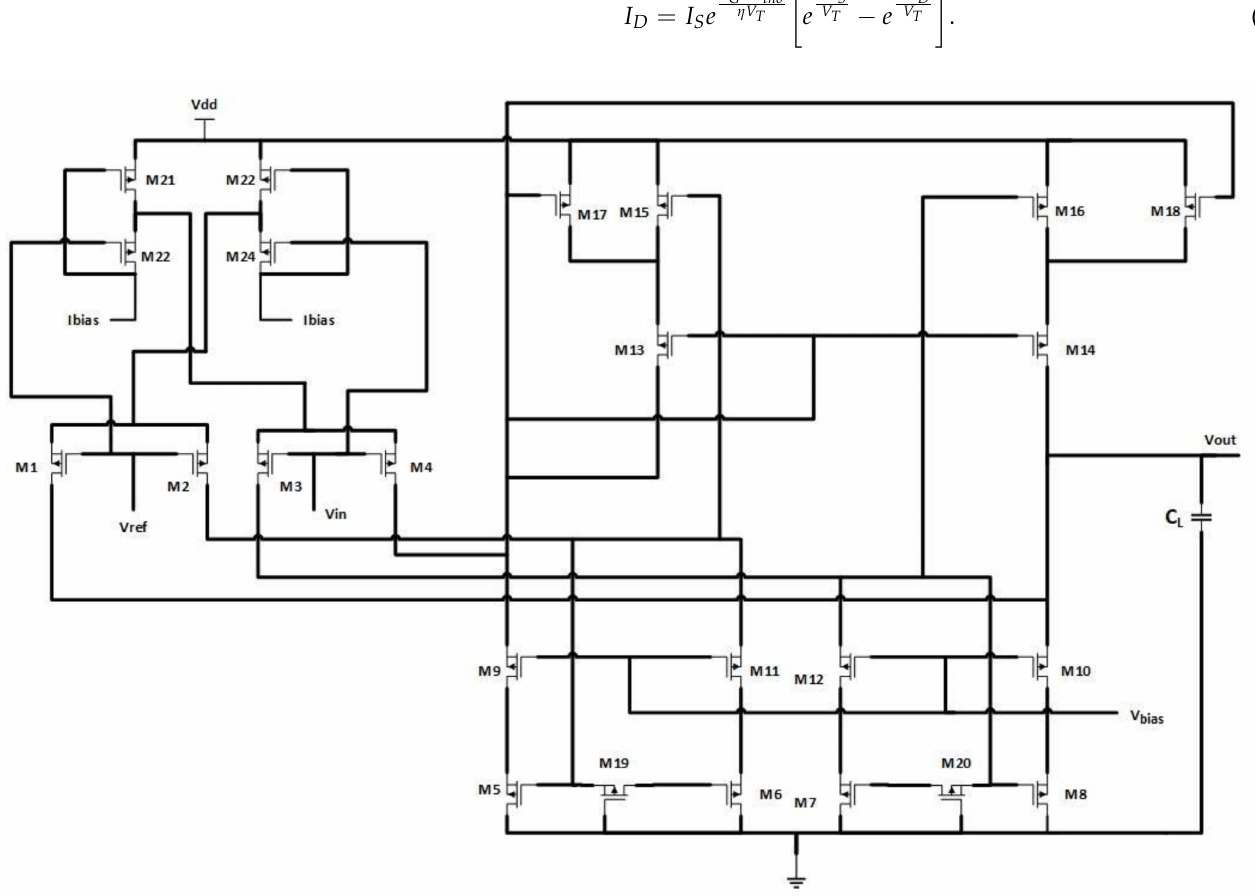
Figure 1. Modified recycling folded cascode